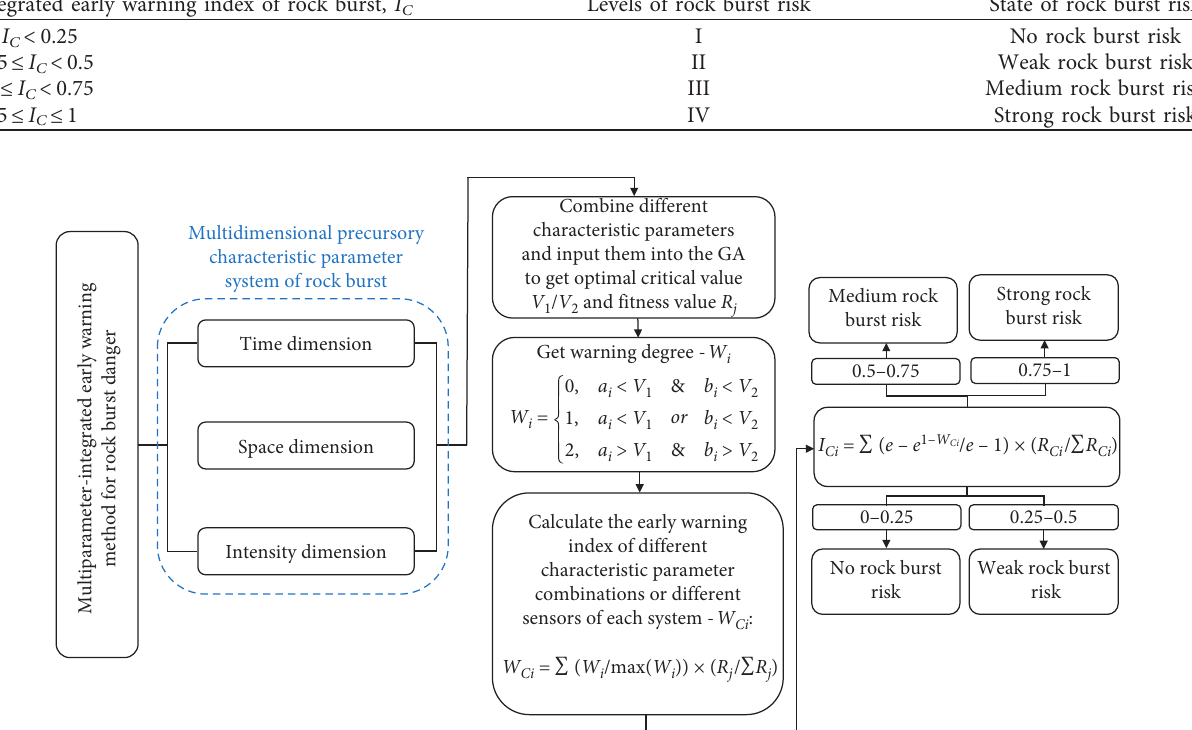
Figure 2: The flowchart of the multiparameter integrated early warning method for rock burst danger.